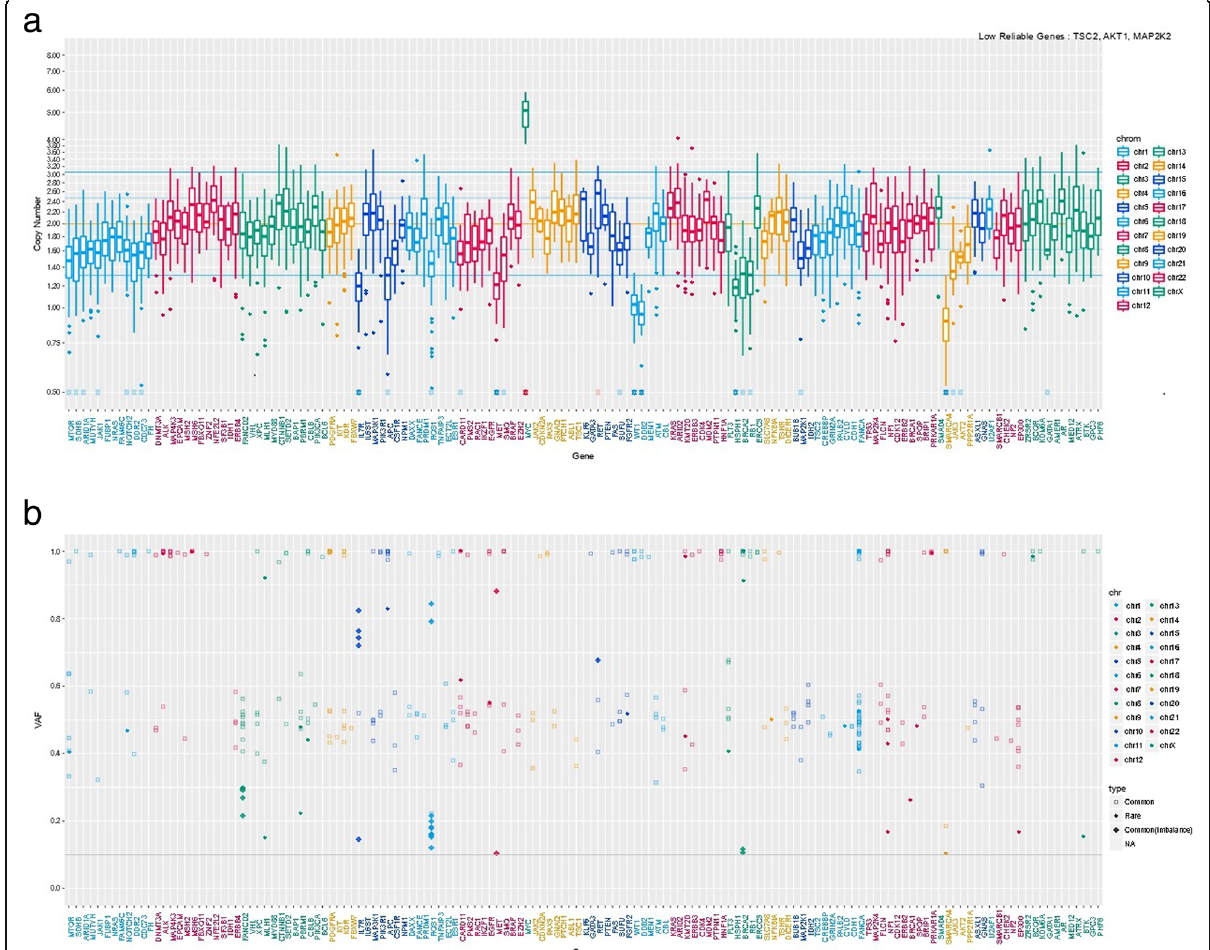
Fig. 2 Results of genetic analysis with ( a ) genes shown on the horizontal axis and copy number on the vertical axis and ( b ) genes on the horizontal axis and variant allele frequency on the vertical